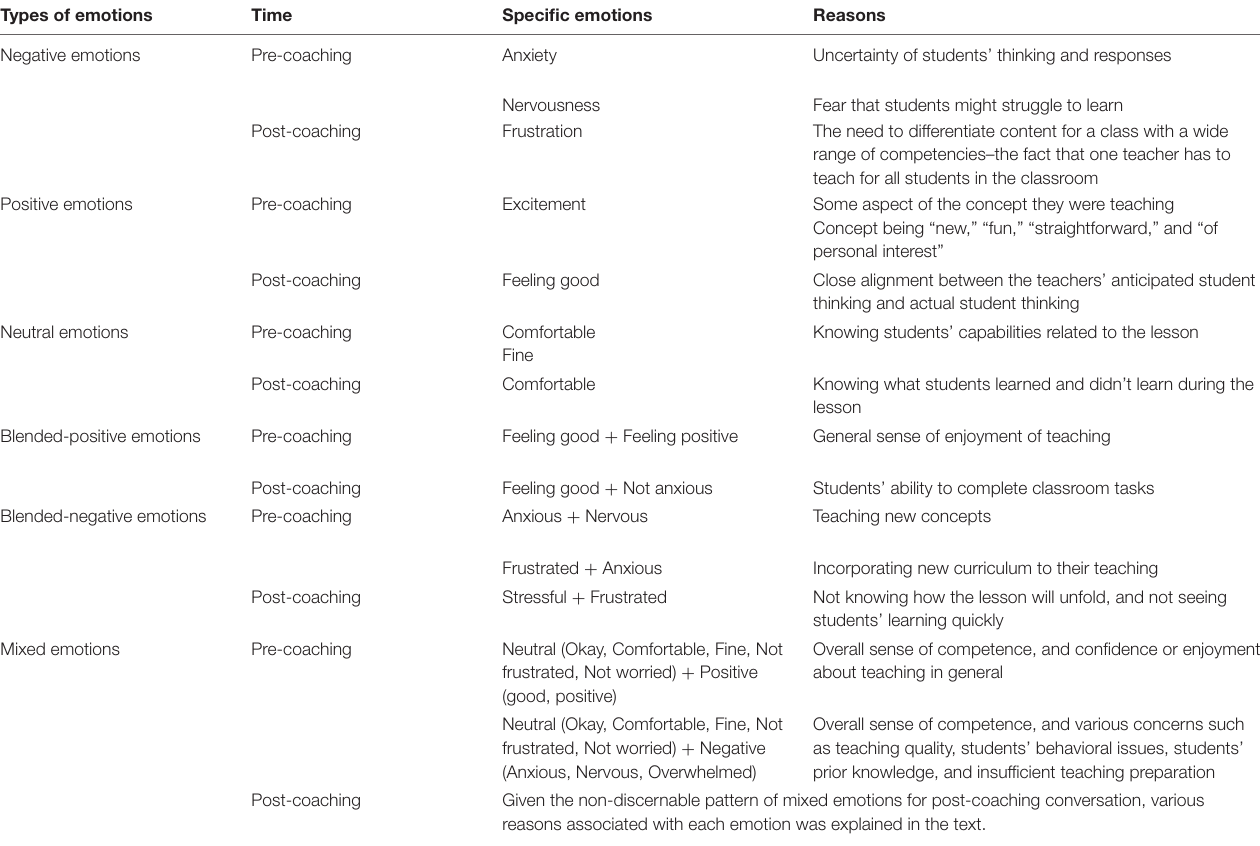
TABLE 4 | Reasons underlying teachers’